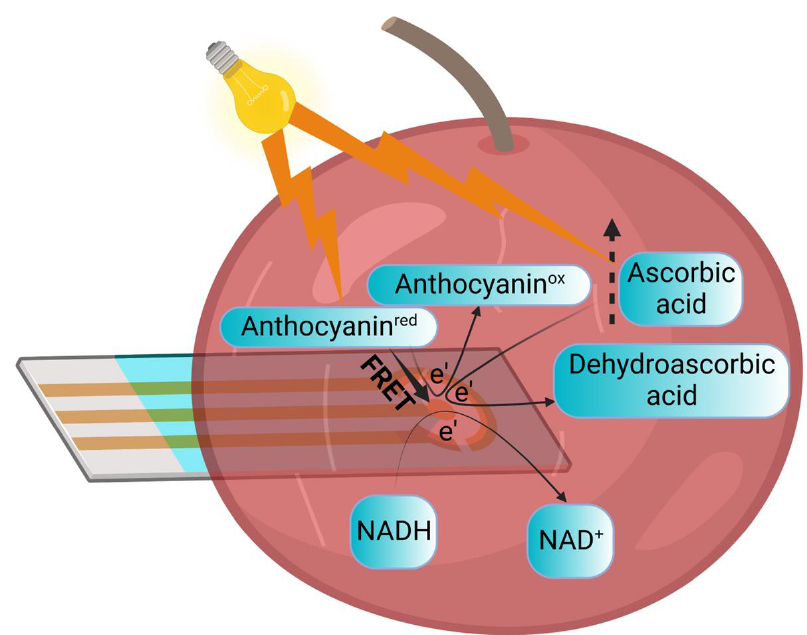
Figure 4. Suggesting a mechanism for the electrical current and photocurrent production. NADH that exists in the cherry can be oxidized at the anode to produce current. The current formation may also originate from ascorbic acid whose formation is induced by light illumination. Another electron donor may be the pigment anthocyanins, which may also conduct Förster energy transfer in light. The light bulb icon and lightning shapes represent the illumination. The round arrows marked with e’ represent the electron transfer between the electron donors and the anode. The dashed arrow represents the elevation of ascorbic acid levels that occur in the light. The solid arrow represents the Förster energy transfer from anthocyanins to the anode.